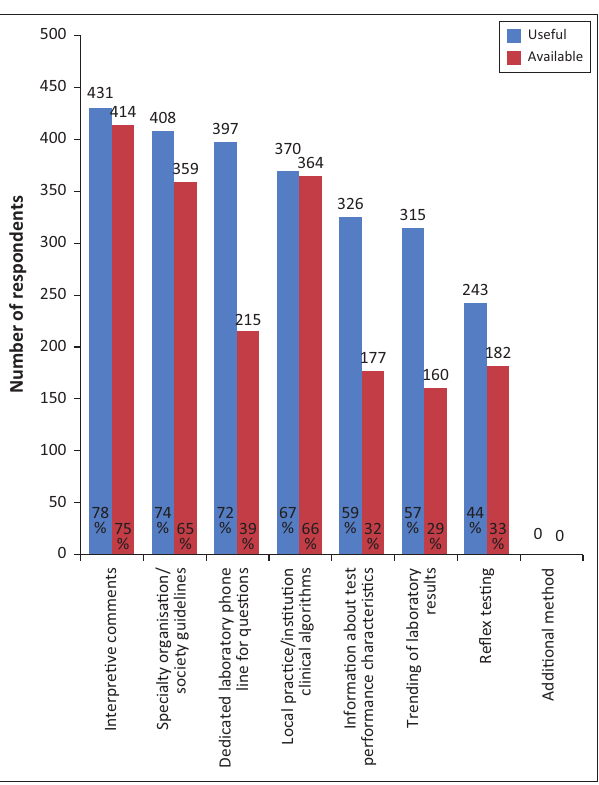
FIGURE 2: Tactics employed by doctors to deal with test interpretation uncertainty, South Africa, 13 October 2015–13 November 2015.